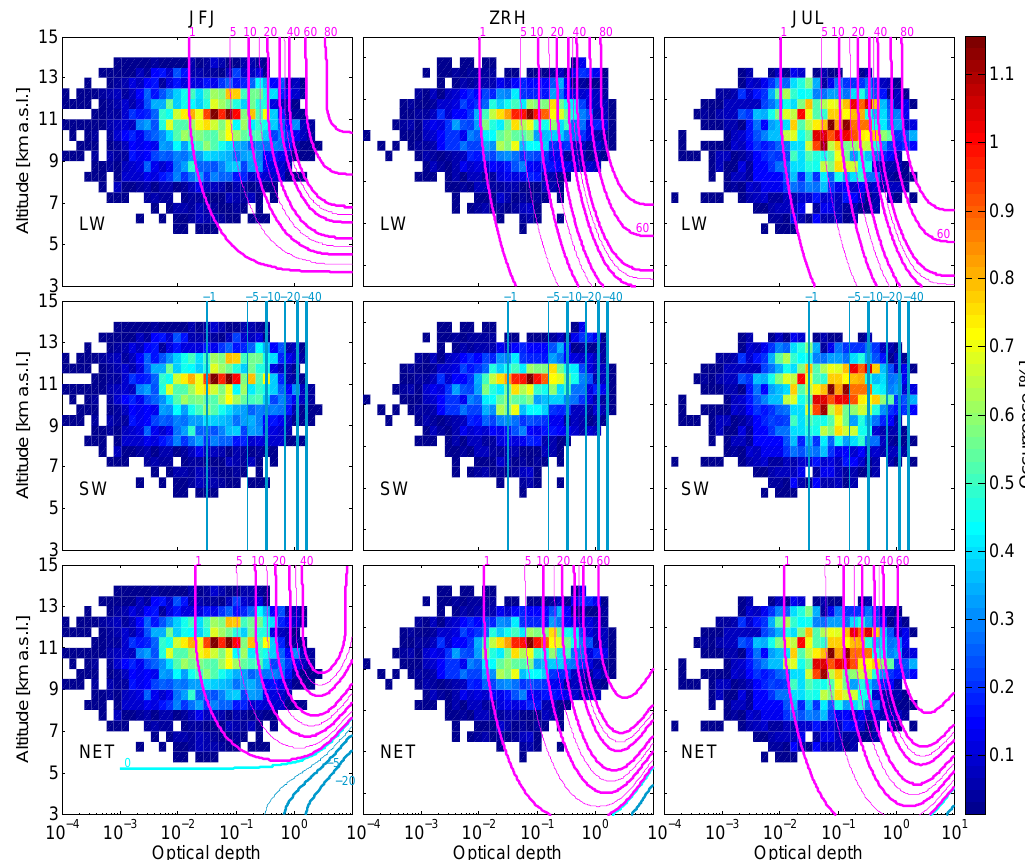
Figure 8. Cloud radiative forcing (CRF) in Wm − 2 for the different sites. Magenta/cyan/blue isolines: positive/zero/negative values in Wm − 2 from the CRF model (Corti and Peter, 2009a). Color coding: Occurrence frequency of cirrus clouds as function of optical depth and cloud top altitude. First row: CRF LW . Second row: CRF SW . Third row: CRF NET .